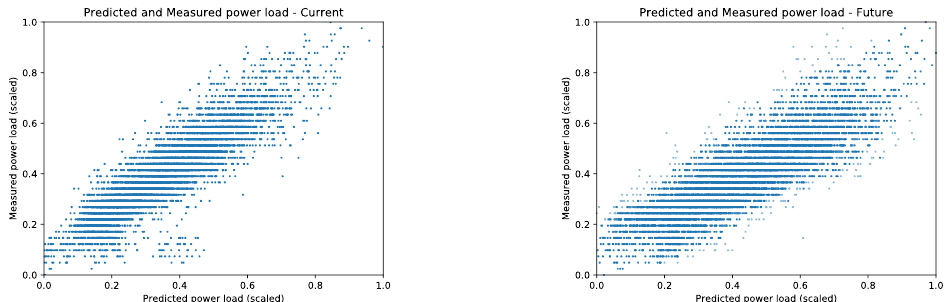
Figure 7. The results of the forecast power load. The x-axis has the predicted power load, while the y-axis has the measured power load. ( Left ) Predicted power load for the current weather conditions with the MSE = 3.61 × 10 − 3 . ( Right ) Predicted power load using the future LSTM weather predictions with the MSE = 3.65 × 10 − 3